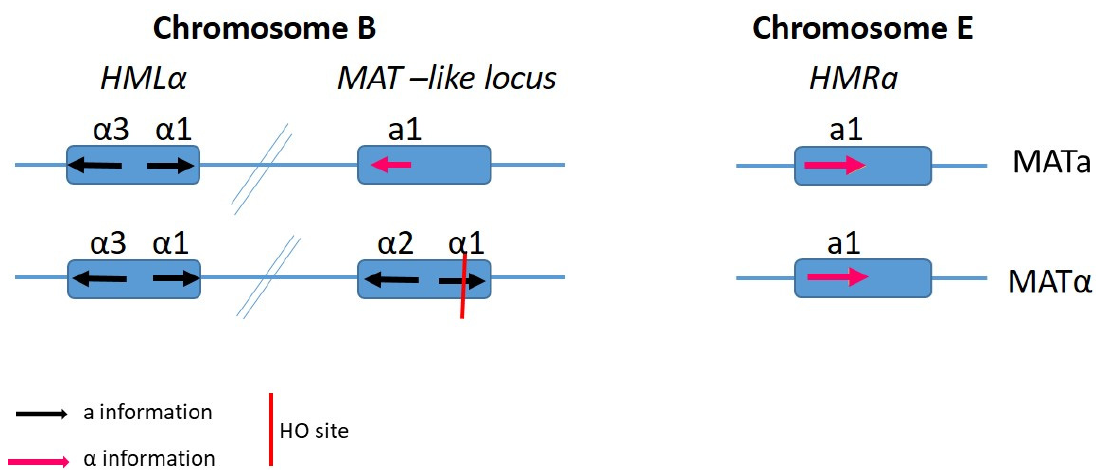
Figure 7. Schematic of the mating-type like (MTL) loci in Candida glabrata. There are three mating-type loci similar to that of S. cerevisiae . The MAT -like loci ( MTL ) determine the strain mating, with the HMR and HML encoding a and α information. The mating-type-loci are mapped to two different chromosomes, with the HML α and MAT locus on chromosome B and the HMR a on chromosome E. There is also an HO endonuclease site on the α 1 gene.